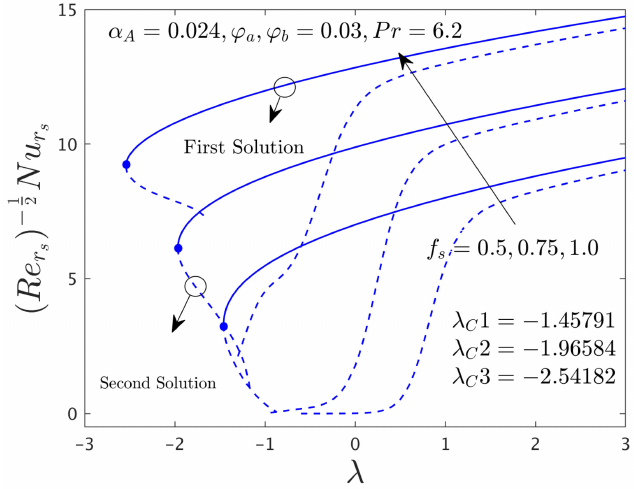
Nu r against λ for numerous choices of f s . s s